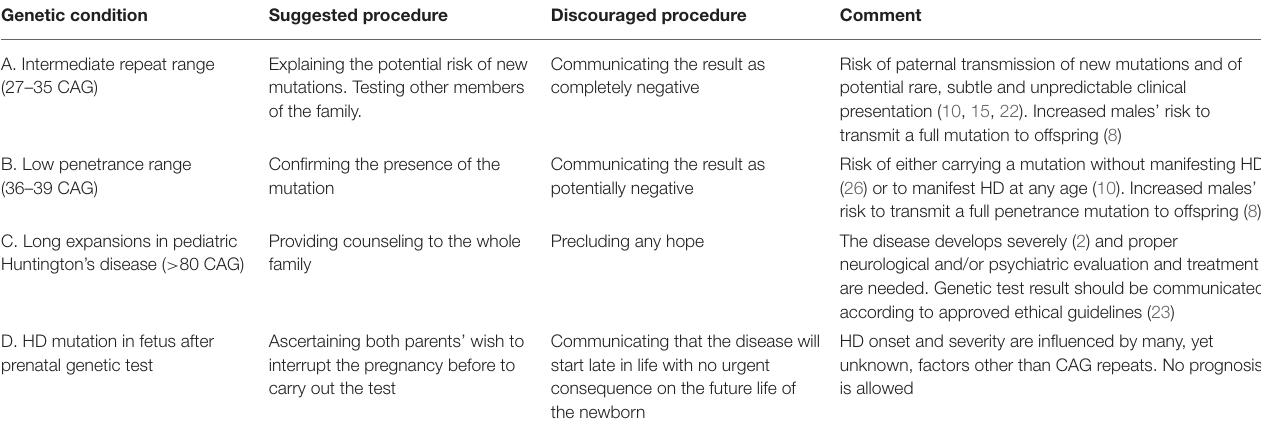
TABLE 1 | Genetic counseling in Huntington